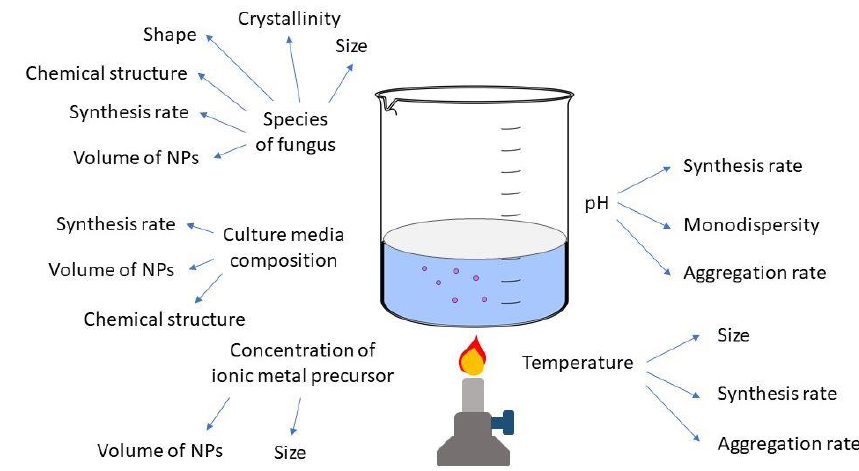
Figure 7. Factors affecting NP synthesis.